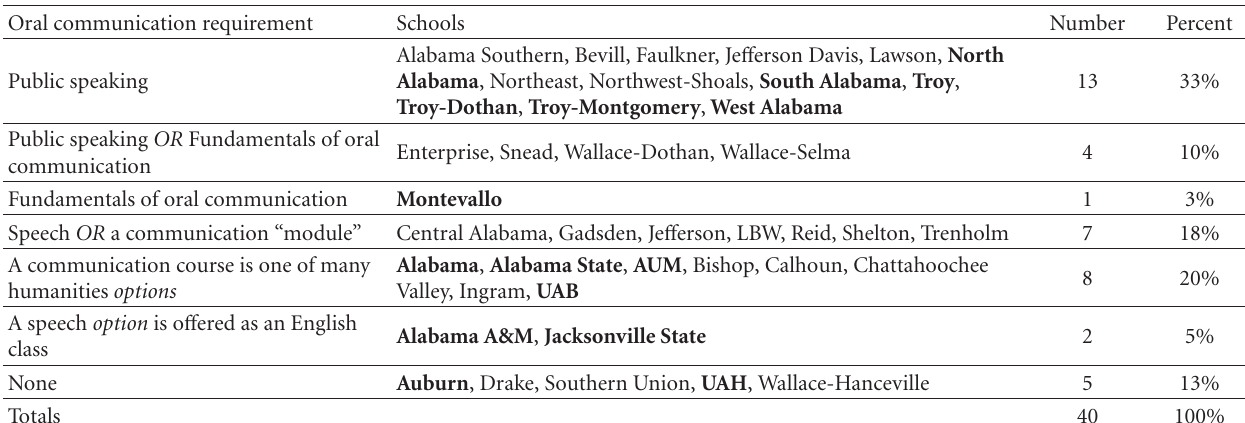
Table 1: Oral communication requirements in the general education curriculum of Alabama’s public two-year colleges and four-year